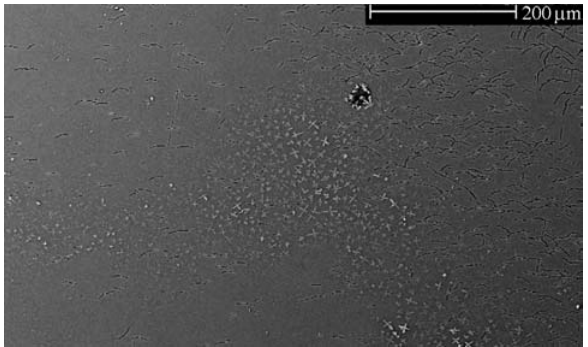
Figure 3. Micrographs of samples without BaO.